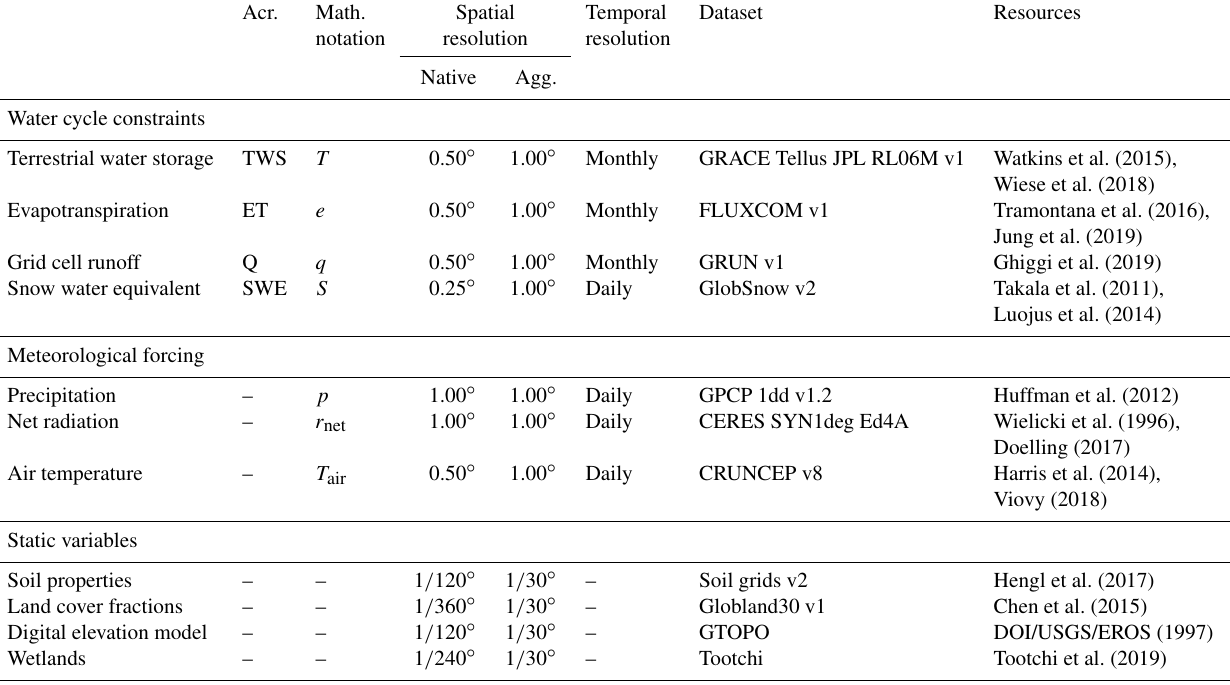
Table 1. Dataset overview, including water cycle constraints, meteorological forcing, and static variables with their native and aggregated spatial and temporal resolution. We use upper case for state variables and lower case for fluxes in the mathematical